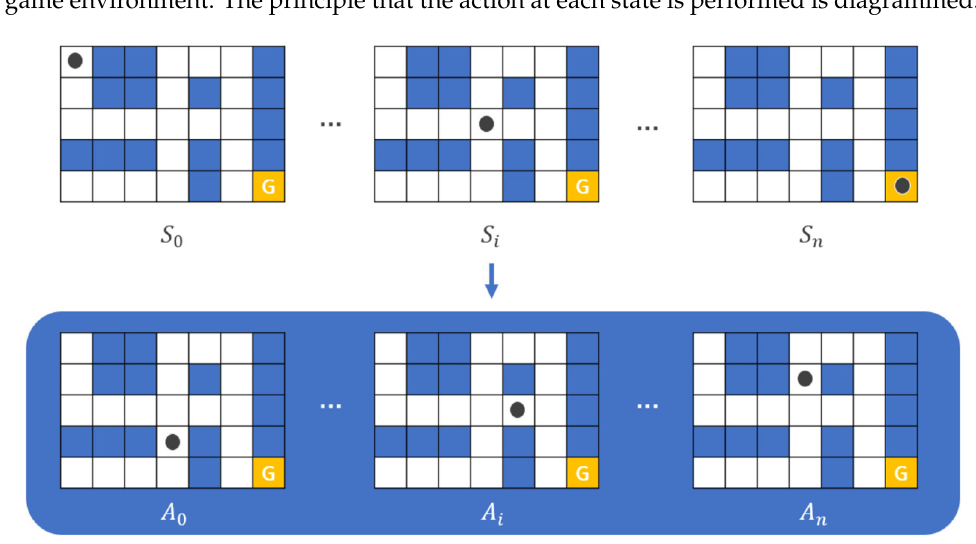
Figure 6. Visualization of reinforcement learning of maze game.